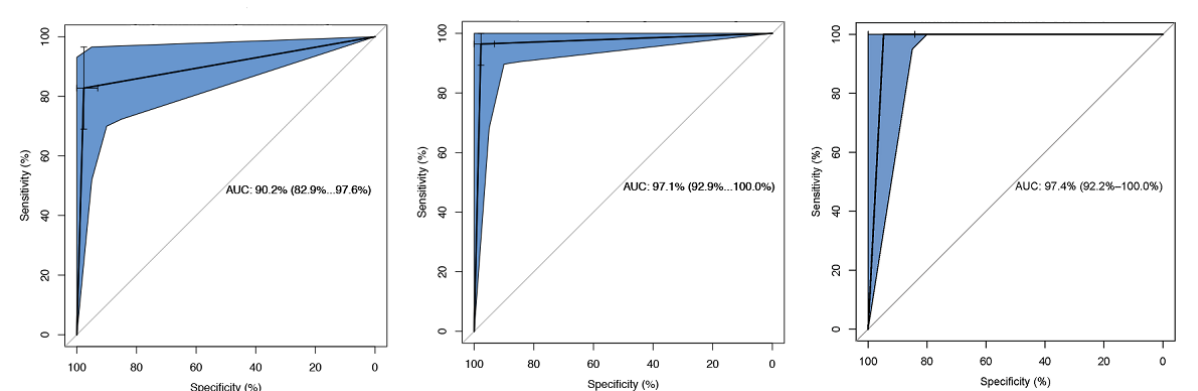
Figure 4. ROC curves from the random forest models based on clinical, laboratory testing, and multimodal features. Left: the symptom feature as the sole input; middle: the laboratory testing feature as the sole input; right: both features combined as the input. AUC: area under the curve; ROC: receiving operator